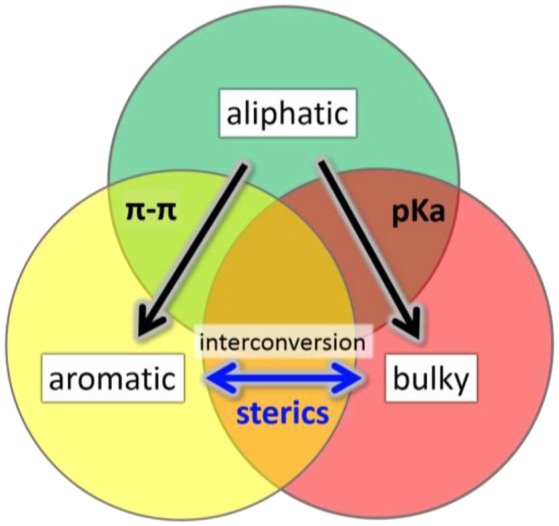
Illustration of overlapping characteristics (π-π interactions, pka values, steric bulk) of the primary, aromatic, and BU tertiary ligands in this work. Arrows show the direction of conversion for Au NMs using these ligand classes.